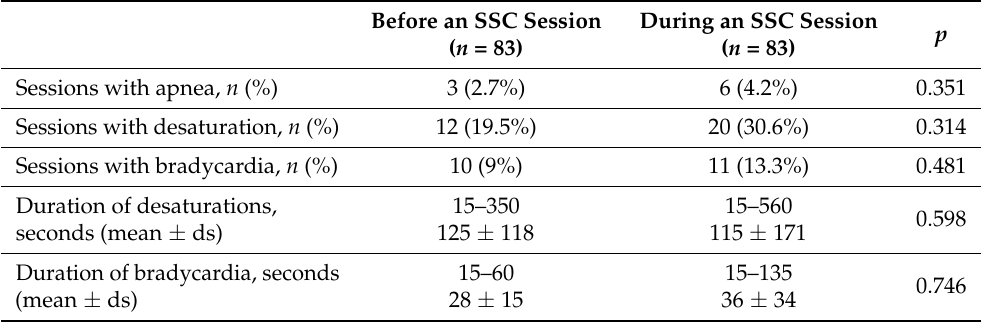
Table 2. Number and duration of apneas, desaturations, and bradycardias during and before an SSC